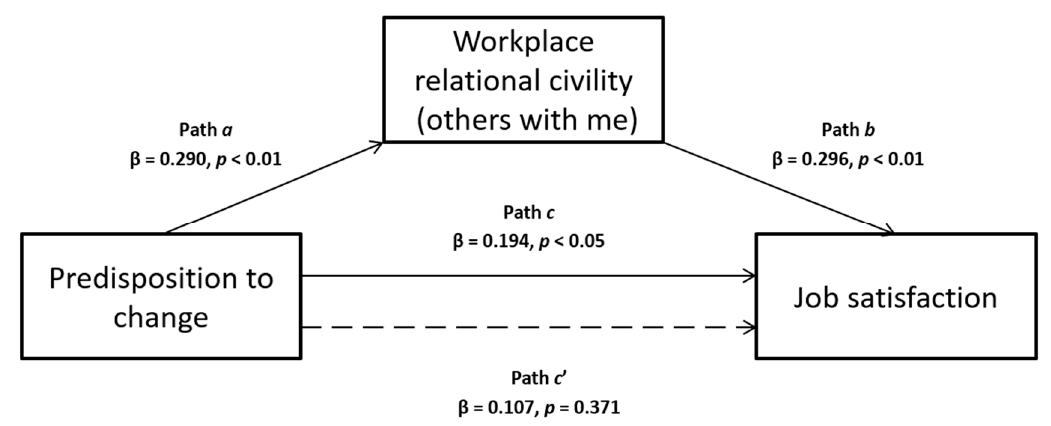
Figure 1. Relationship between predisposition to change and job satisfaction with workplace relational civility (others with me) as mediator.